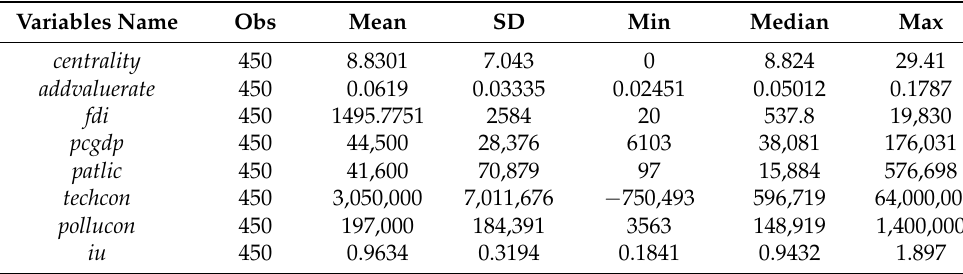
Table 1. Descriptive statistics of